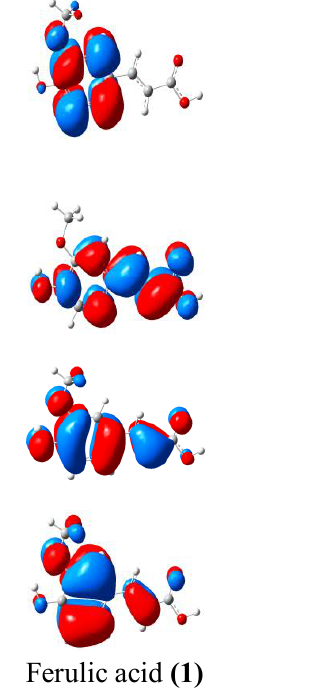
Figure 3: The frontier and second frontier molecular orbitals of Ferulic acid (1) and Chenodeoxycholic acid (2) .